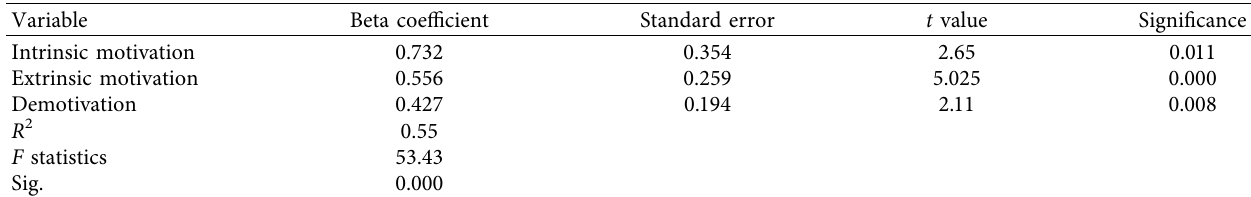
Table 9: Linear regression